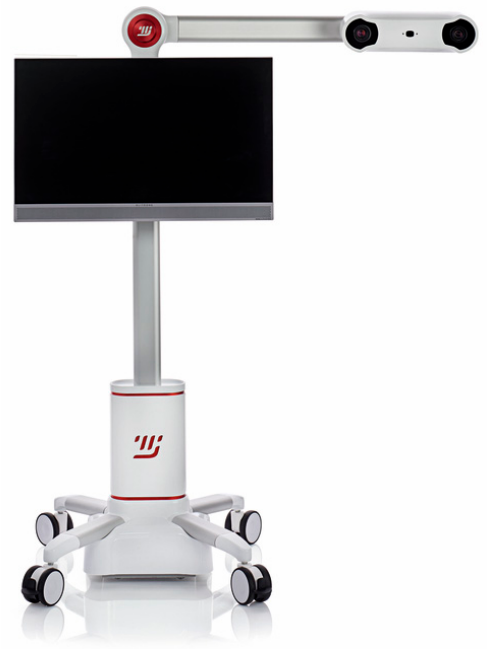
Figure 1. The ModJaw device with a camera based on 3D stereophotogrammetry to record mandibular movements on STL models.